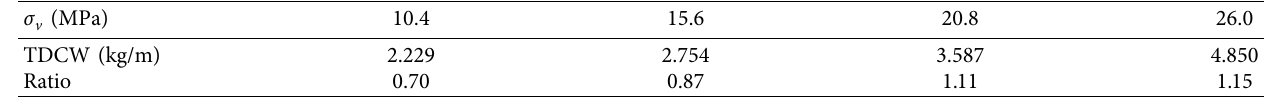
Ratio, ratio of theoretical calculation results to average value of experimental